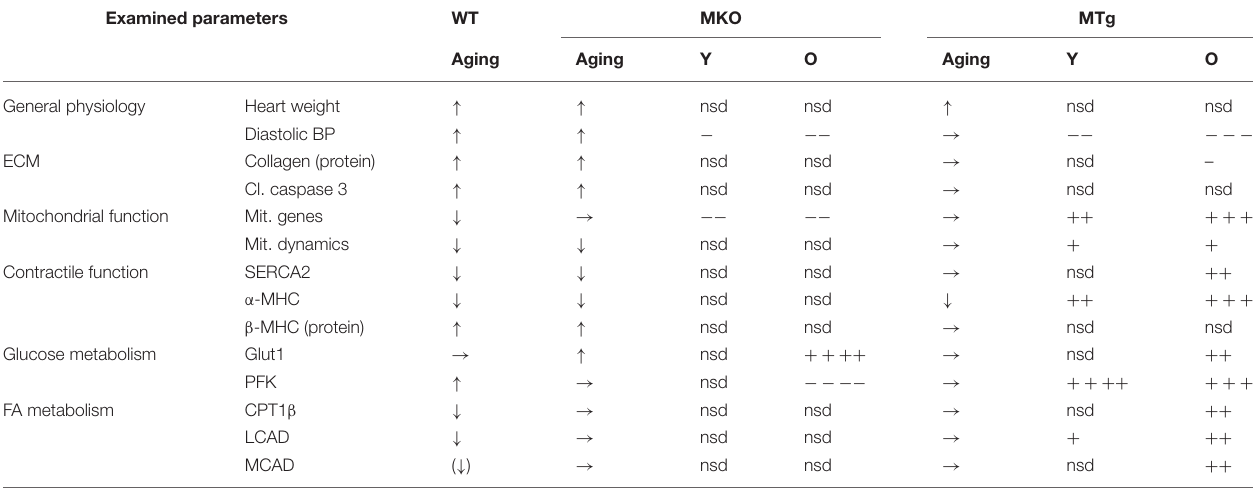
TABLE 3 | Overview of age-related changes in WT, MKO, and MTg groups and of the MKO and MTg compared to WT animals. Examined parameters WT MKO MTg Aging Aging Y O Aging Y O General